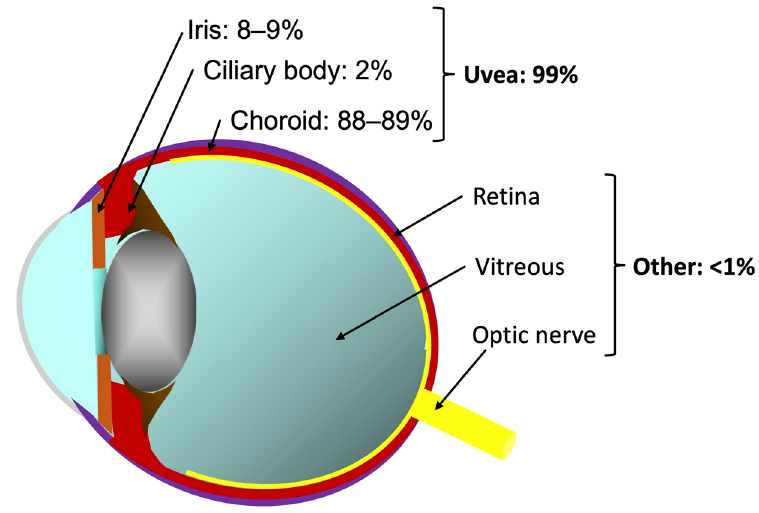
Figure 1. Ocular metastasis localization.